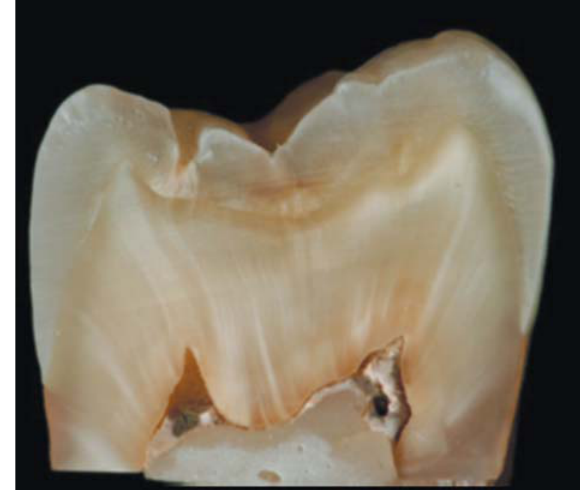
Figure 2- Appearance of Group 1 (MTA Fillapex) after 3 months. Color stability of MTA Fillapex sealer within its mass and absence of dentinal